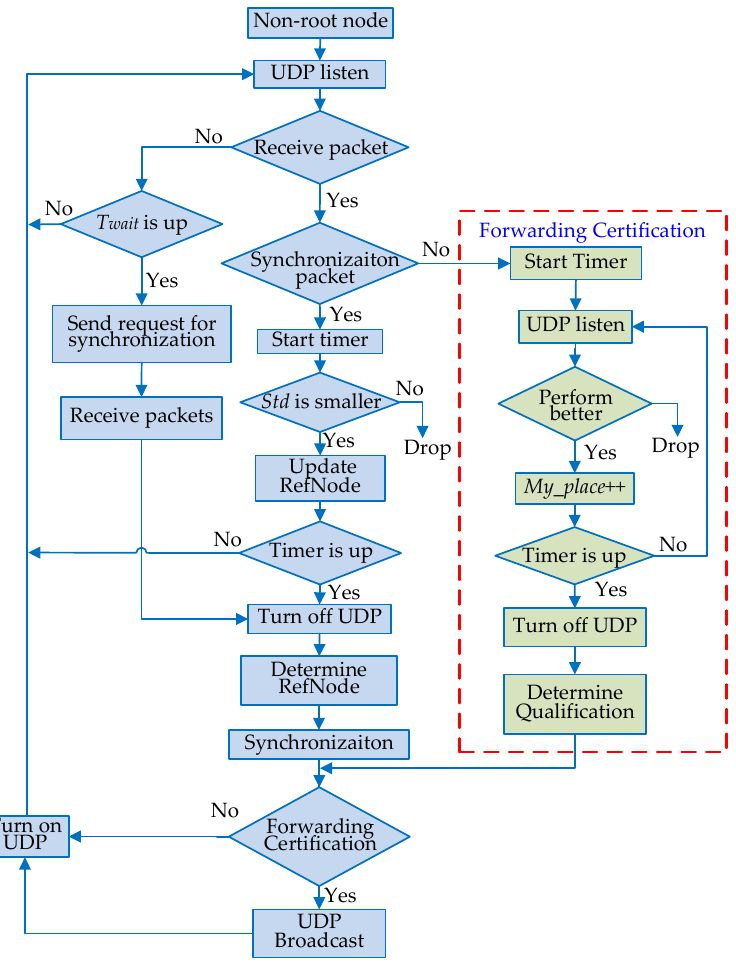
Figure 4. Synchronization flow chart of the non-root node.